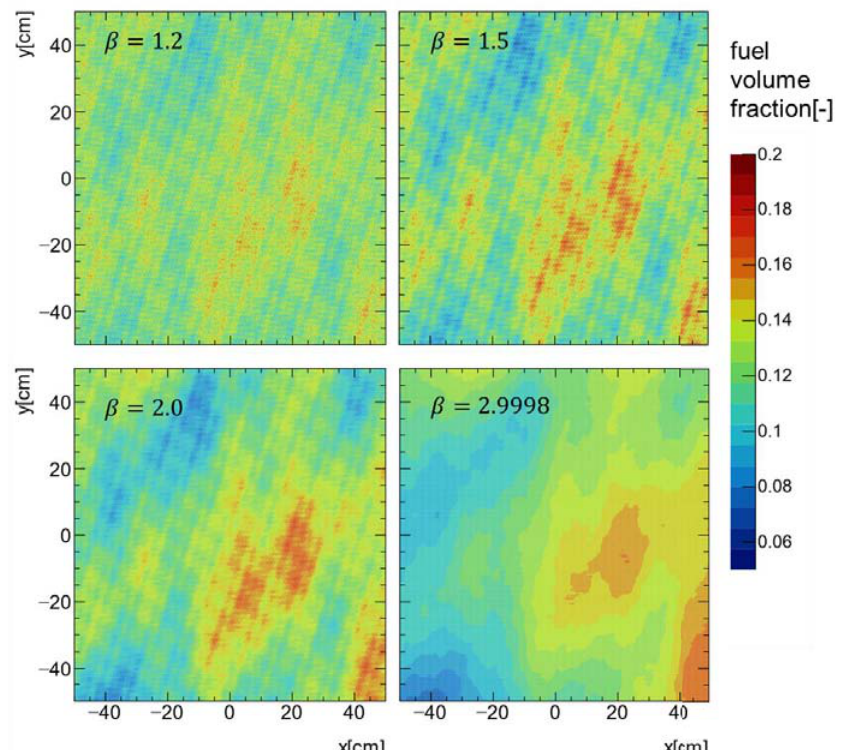
Figure 7. Sample of 2-dimensional random media which were generated by the 1/f β noise model and characterized by different the β value with the same random variable series. The mean volume fraction of fuel was 12.5%. The upper left, upper right, lower left, and lower right figures show the case of β=1.2, 1.5, 2.0, and 2.9998, respectively. The contour color indicated the volume fraction of fuel in the